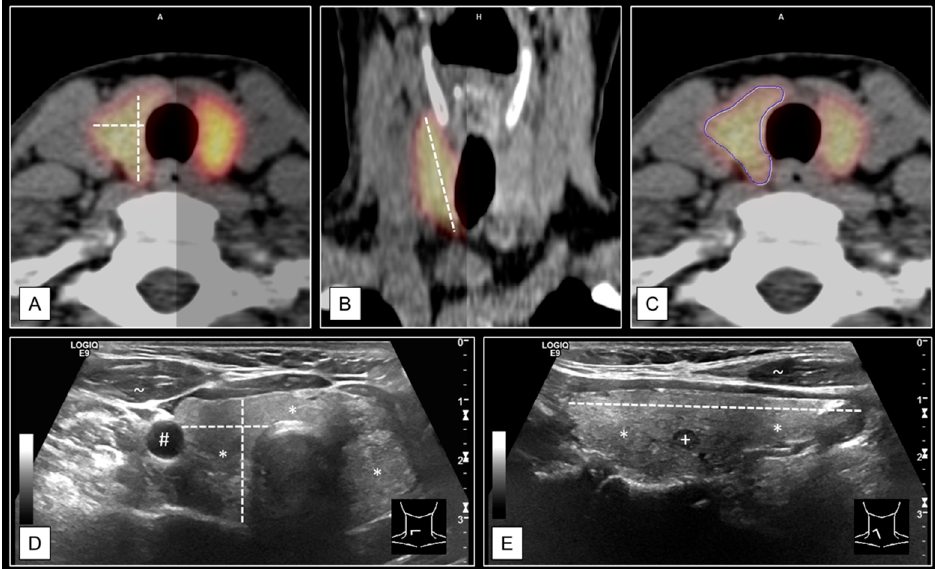
Figure 2. Thyroid gland volume determinations on computer tomography (CT) and ultrasound (US). The example shows a slightly enlarged right thyroid lobe (11.8 mL) of a 69-year-old female. Measurements were recorded on the axial and coronal planes for ellipsoid model determinations on CT ( A , B ). The corresponding I-124-positron emission tomography (PET) images were superimposed to the CT images for the purpose of optimal accuracy due to the poor soft-tissue contrast of low-dose CT scans. The CT-to-PET ratio was optimized for each measurement (examples: A, left side 80:20, A, right side 50:50; B, left side 75:25, B, right side 100:0). Furthermore, the contours of both thyroid lobes were manually traced via syngo.via™ software (Version VB40, Siemens Healthcare GmbH, Erlangen, Germany), on every single axial plane of PET/CT images ( C ). US volume determinations were carried out according to the ellipsoid model method on axial ( D ) and sagittal ( E ) plane for each thyroid lobe. Labels: * thyroid tissue, + thyroid nodules (TN), # carotid artery, ~ muscle tissue.